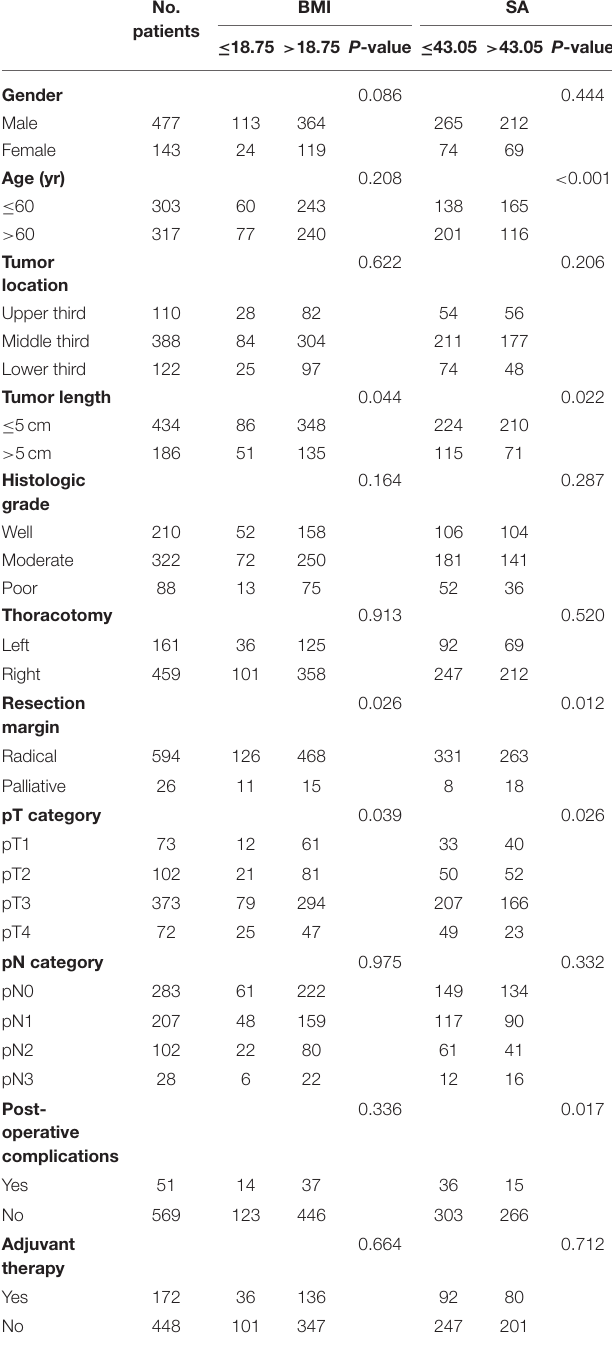
TABLE 1 | Correlation of the body mass index and serum albumin with the clinicopathological